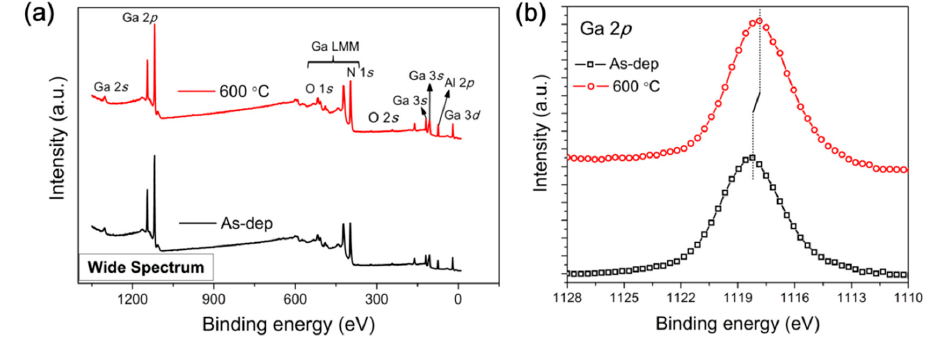
Figure 4. ( a ) Wide survey spectrum and ( b ) Ga 2 p energy level of XPS for the PdAl / Au metal stack on p-AlGaN before and after annealing at 600 ◦ C.